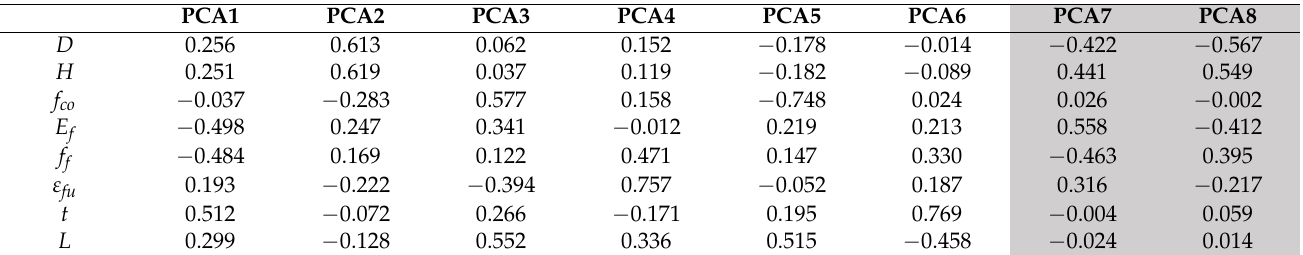
Table 4. PCA components, with PCA1-6 having impact on data calculations. Grey-shaded cells are removed from